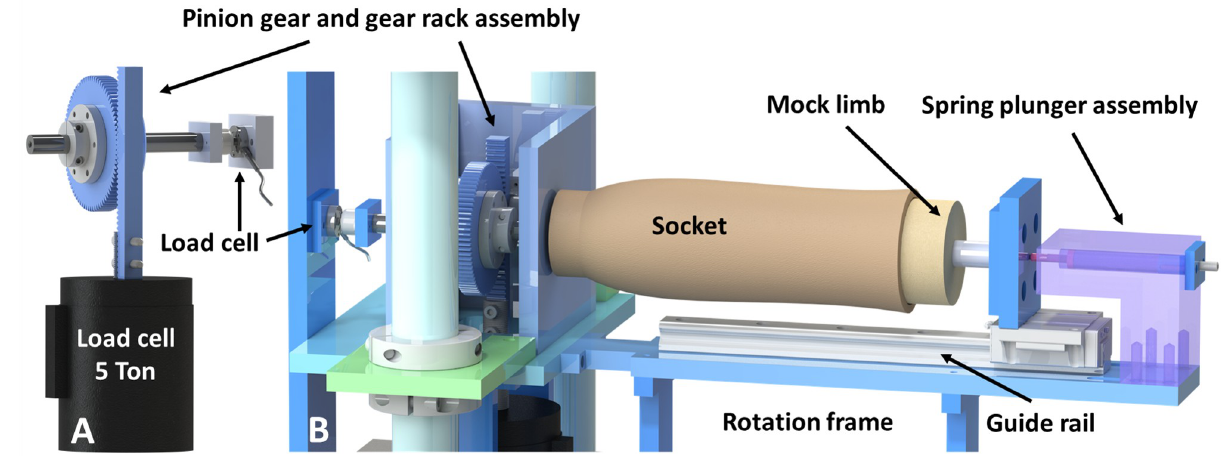
Fig 3. A. Pinion gear and gear rack assembly close up. B. Rotation assembly close up, transparent detail of spring plunger assembly.